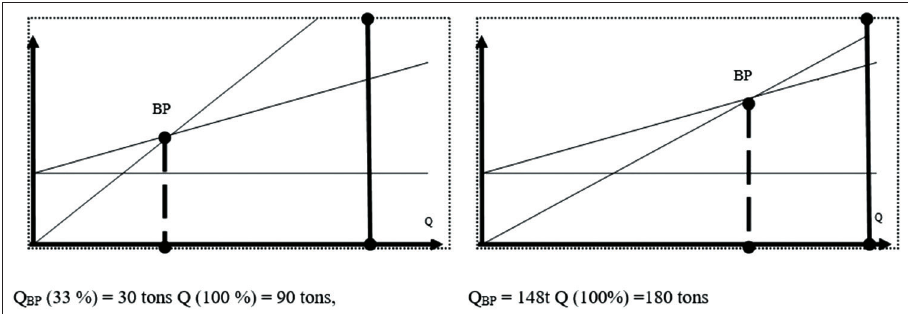
Figure-2: Break-even kumis output volume when horses are kept in herds and on pastures. Table-1: Economic characteristics of production types (industries) of the pilot area. Type of